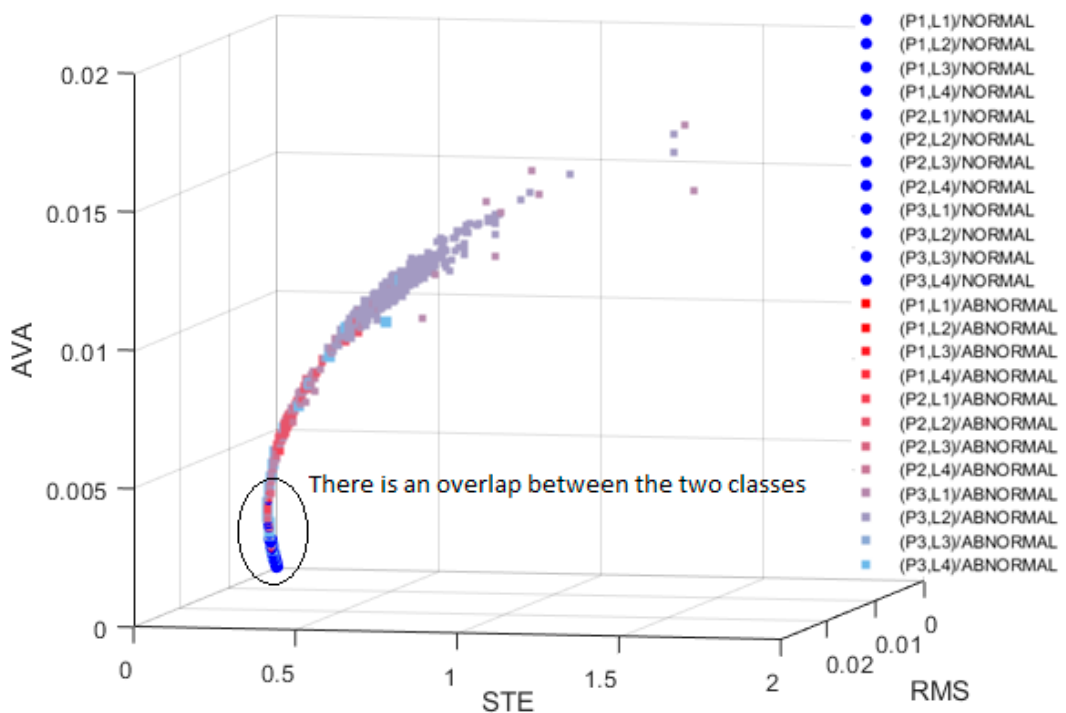
Figure 12. State scattering based on features extracted from the AE signal on channel 1 (CH1).